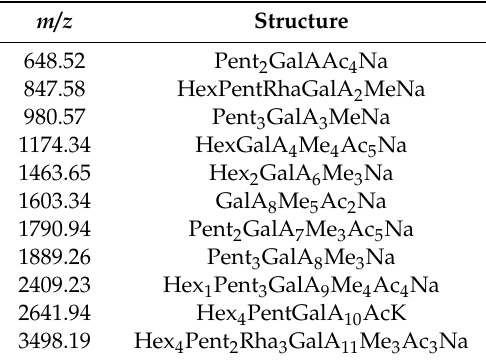
Table 3. MALDI-TOF results and suggested structures of autohydrolysis liquors at 140 °C.